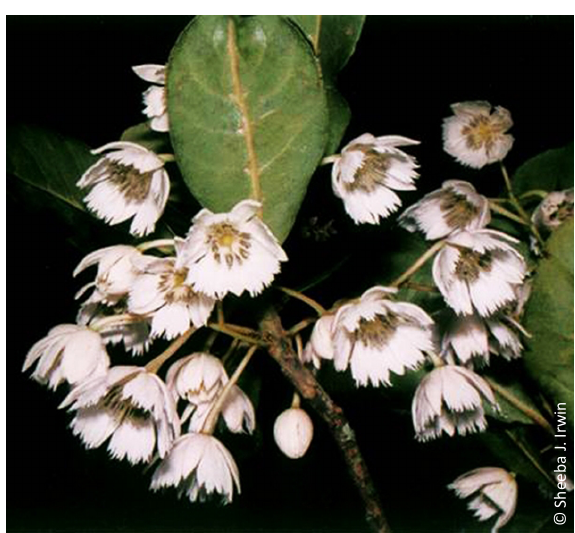
Number Number of of taxa endemic recorded taxa